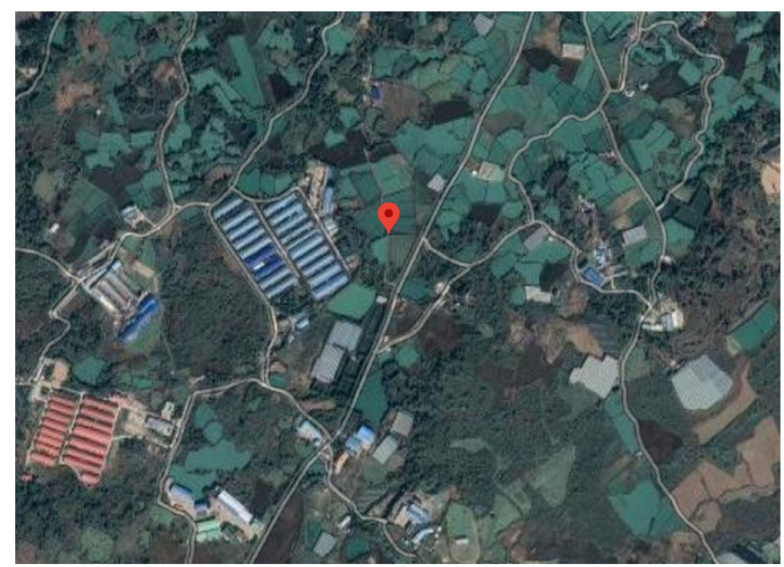
Figure 2. Satellite map of the radish fields (33 ◦ 30 (cid:48) 5.44” N, 126 ◦ 51 (cid:48) 25.39” E), where the radish dataset was collected (Google map image).